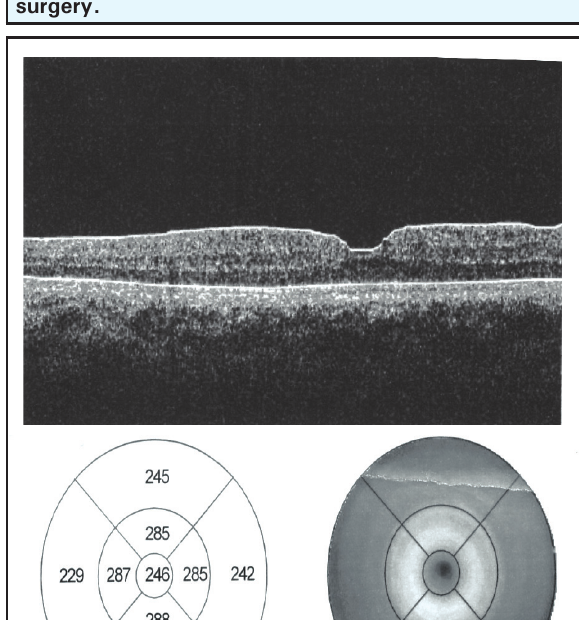
Figure 2. OCT showing Epiretinal membrane before surgery.